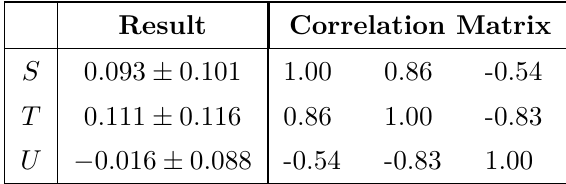
Table 2. Results for the fit of the oblique parameters S, T and U without R b